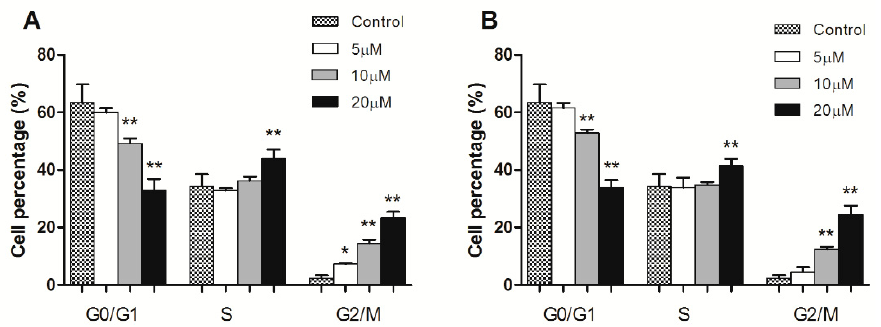
Figure 4. Cell cycle analysis of HeLa cells treated with compounds 3 and 4 (5 μ M, 10 μ M, and 20 μ M) for 24 hours by flow cytometry.